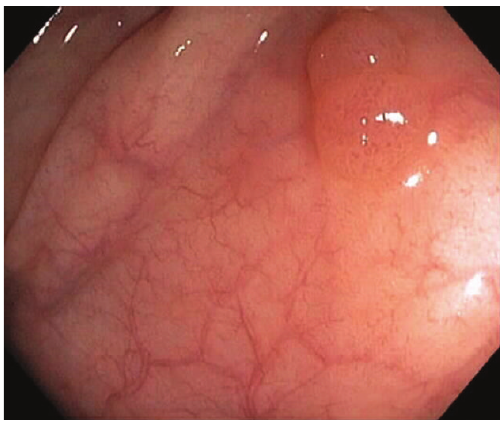
Figure 3: Circumferential wall thickening of transverse